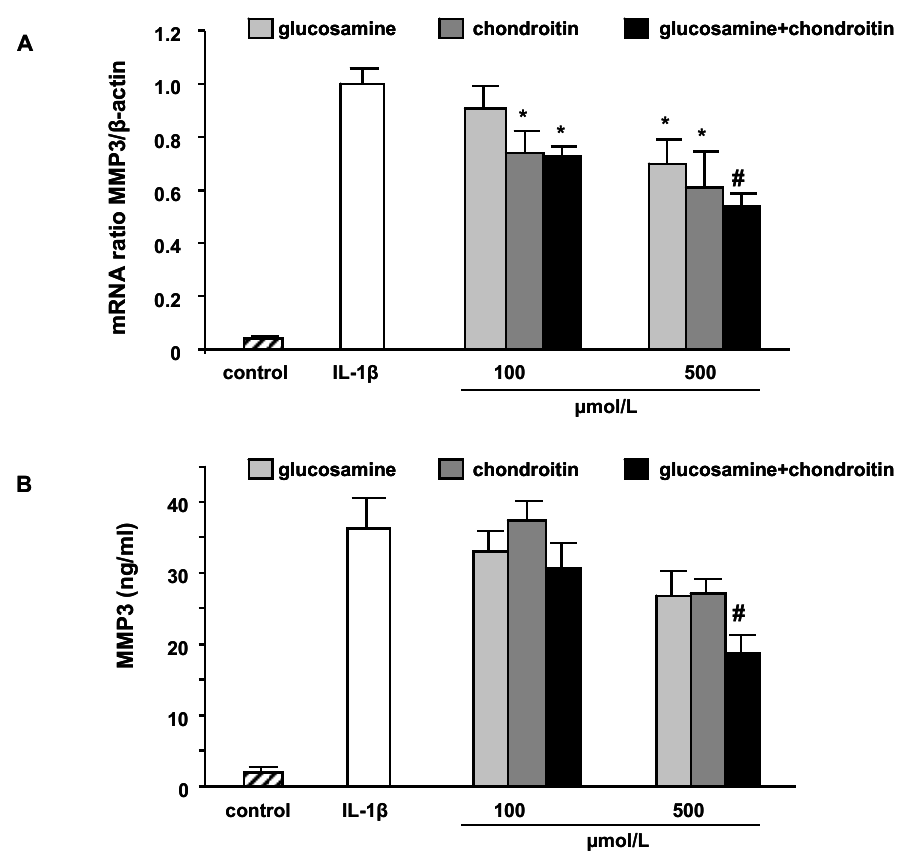
Figure 4. Effect of glucosamine and chondroitin on MMP3 mRNA levels (A) and protein secretion (B) in IL-1 β stimulated SW1353 cells. Cells were stimulated with IL-1 β (10 ng/mL) in the presence of different concentrations of glucosamine, chondroitin and the combination of both test compounds for 24 h. Cell culture supernatants were collected and the amount of MMP3 secreted by SW1353 cells was measured by specific ELISA. Results for MMP3 mRNA are calculated in relation to β -actin and compared to IL-1 β -treated cells. Data are means + SEM of three independent experiments performed in